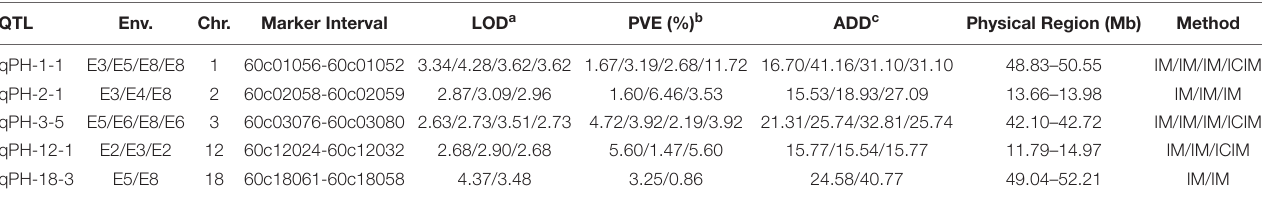
FIGURE 3 | Frequency of QTL for plant height on 20 chromosomes in RIL 6013. TABLE 4 | Five QTL detected in multiple